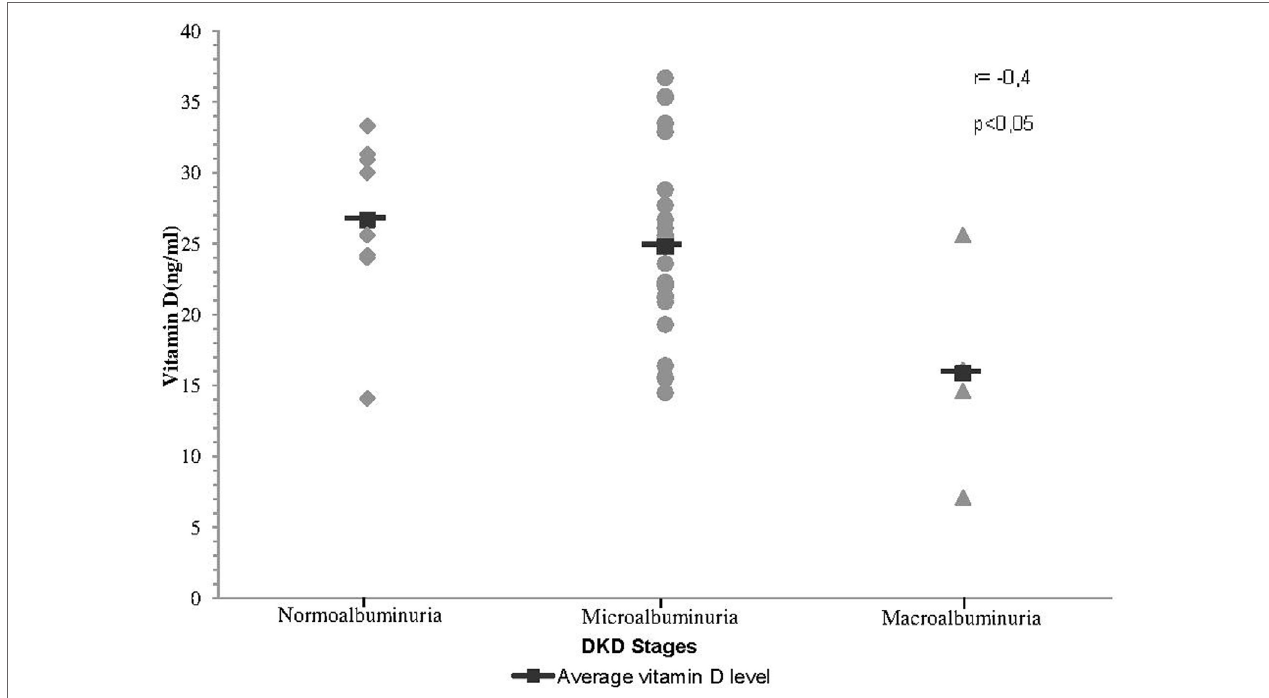
FigUre 3 | correlation between VD levels and stages of DKD .